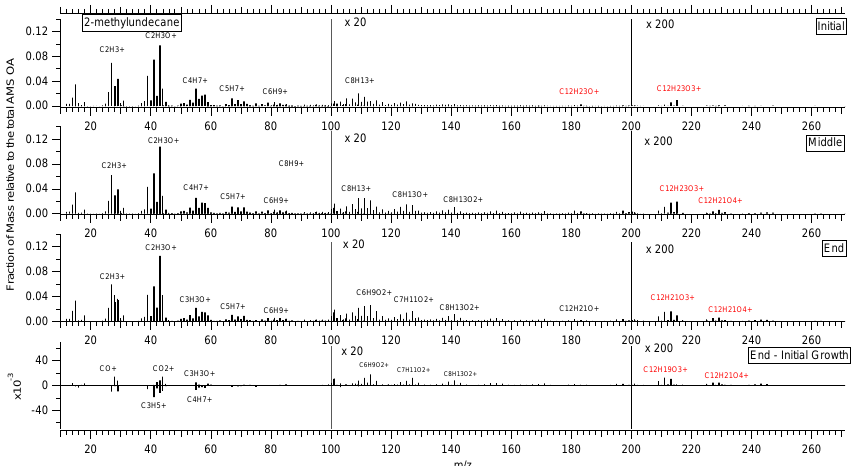
Fig. 5. High-resolution mass spectrum of SOA formed from 2-methylundecane at initial organic growth, mid-experiment, and end of exper- iment. The difference spectrum is also shown. m/z 101–200 are multiplied by 20, and m/z 201–300 are multiplied by 200 for visual clarity. Ions with high signal are labeled. Ion labels in red correspond with proposed ion assignments in Table 5.